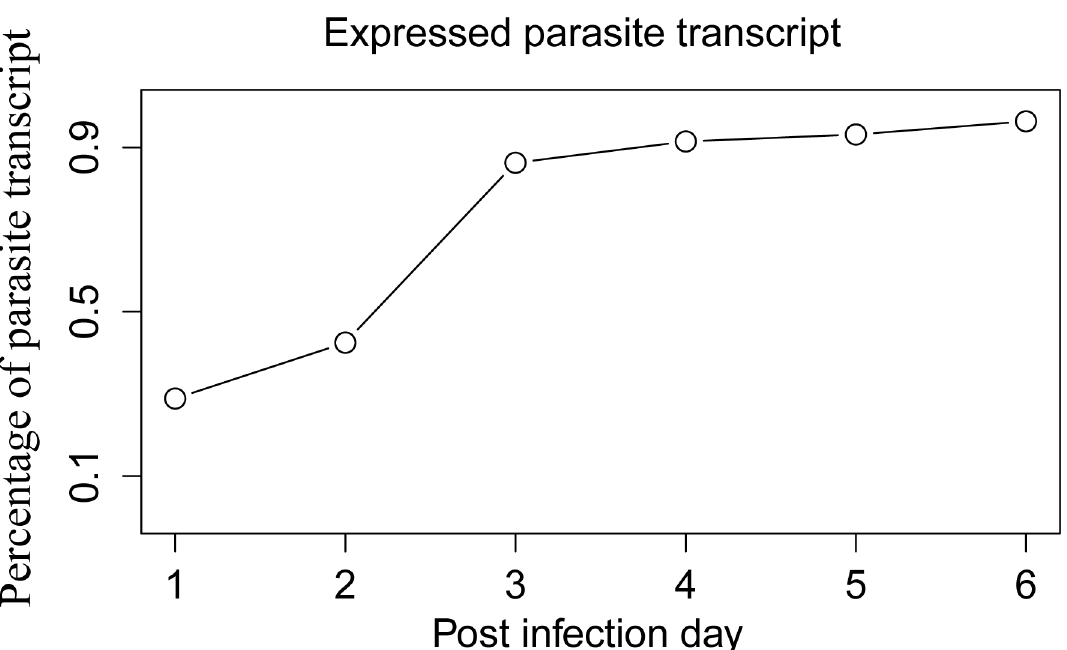
Fig 1. Percentage of total N . ceranae transcripts detected over the infection period. Over 28% of N . ceranae transcripts were detected to express as early as 1 dpi. The expressed transcripts increased dramatically from 42.5% at 2 dpi to 91.5% at 3 dpi, followed by a steady increase to 96.4% at 6 dpi. The largest increase in the expressed transcripts was between 2 dpi and 3 dpi, which might reflect an increase in meront reproduction and sporonts